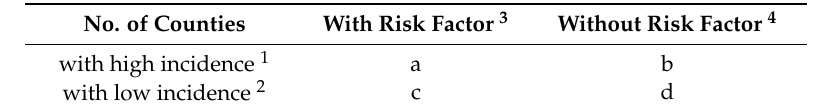
Table 1. Odds ratios calculation scheme.